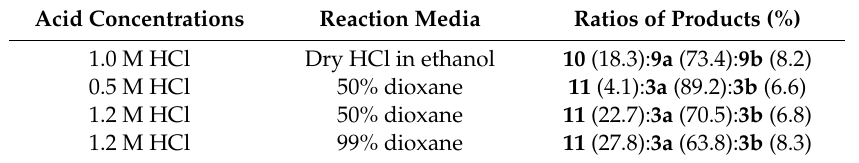
Table 2. The molar ratios of products from FA dilactone under various acidic conditions*.